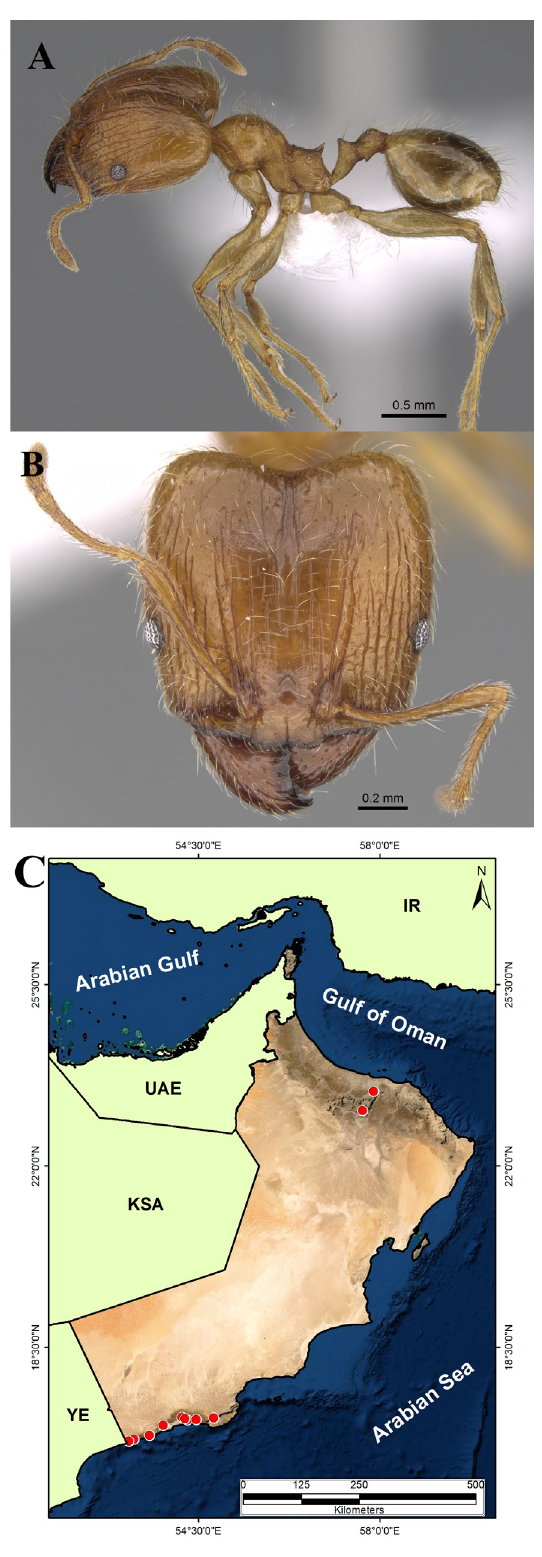
Fig. 45. Pheidole megacephala (Fabricius, 1793), major worker (CASENT0922894, AntWeb.org (Michele Esposito)). A . Body in profile. B . Head in full-face view. C . Distribution